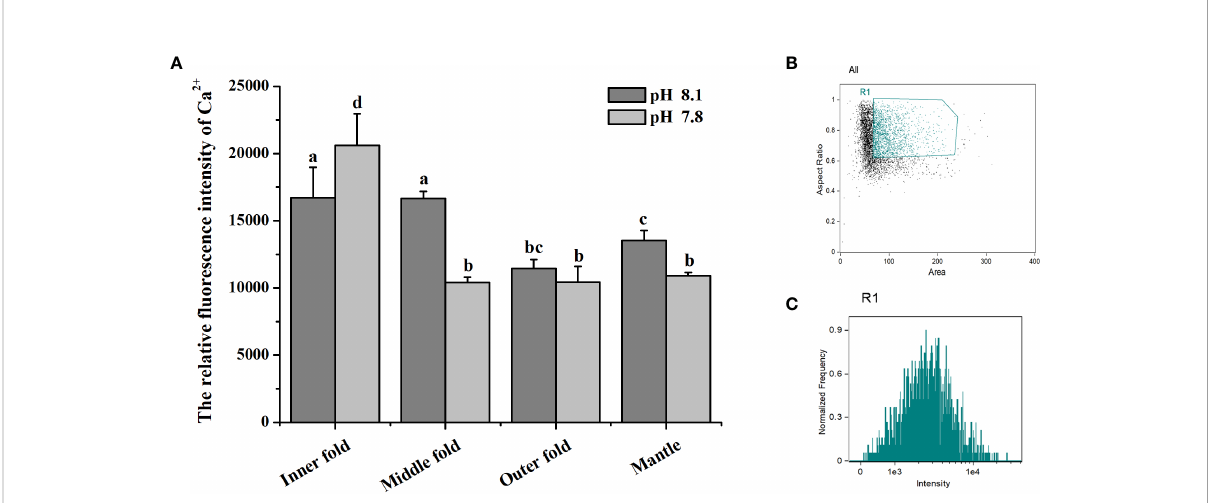
FIGURE 6 (A) Ca 2+ content in oyster mantle cells of control group and CO 2 treatment group. Each value was shown as mean ± S.D. ( N = 3), and the signi fi cant differences ( p < 0.05) were marked by different letters (a-d). (B, C) Flow cytometry analysis about the fl uorescence intensity of mantle cells incubated with Fluo-4